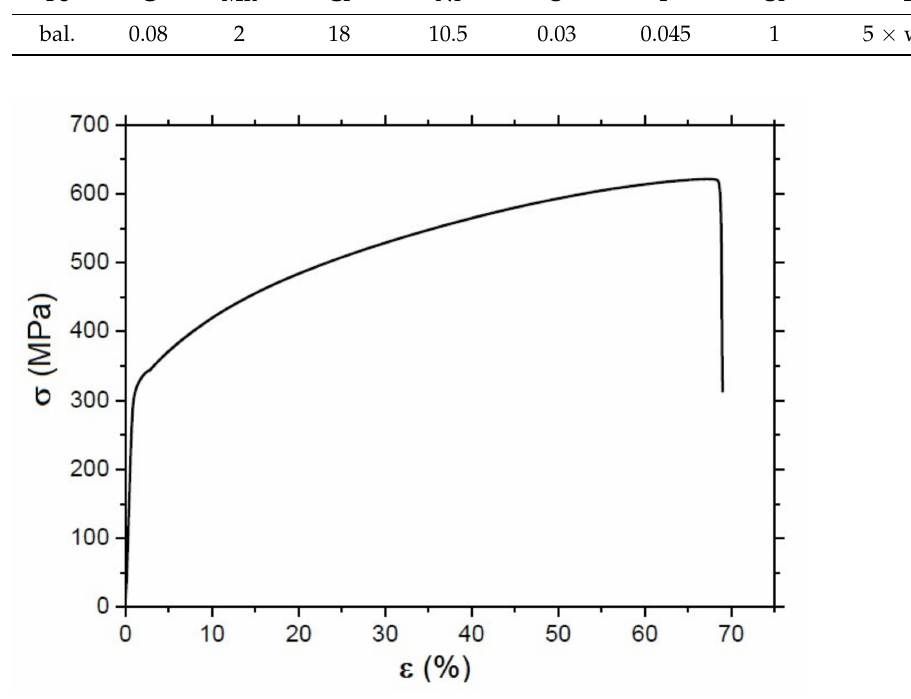
Figure 2. Stress–strain (engineering) curve of AISI 321, strain rate 0.33 × 10 − 3 s − 1